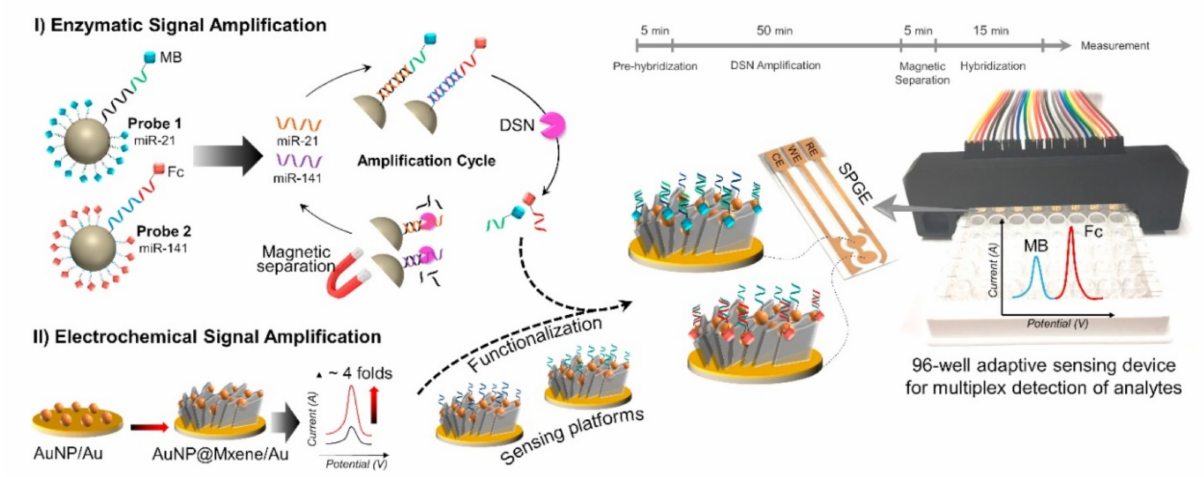
Figure 7. Schematic diagram representing the biosensing assay for simultaneous detection of miR-21 and miR-141. ( I ) Enzymatic signal amplification was performed based on DSN-assisted target recycling approach followed by magnetic separation; ( II ) Electrochemical signal amplification was achieved via the Au electrode modification with AuNP@MXene. Reprinted from [89] with permission from